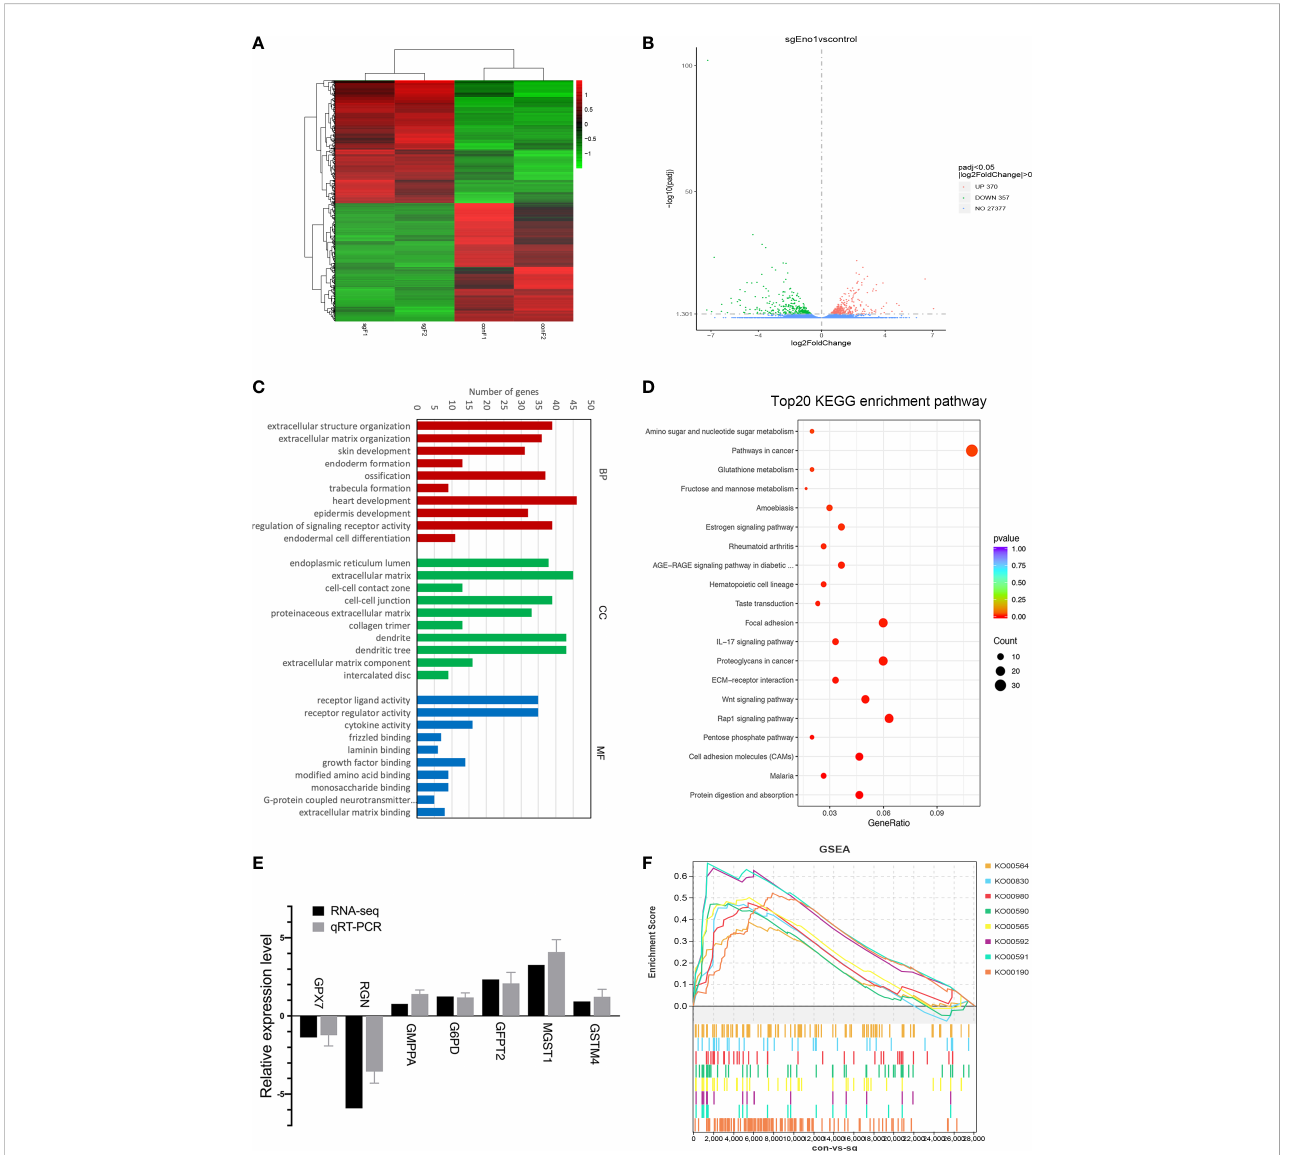
FIGURE 6 RNA-seq analysis of DEGs in control and ENO1 knockout groups. (A) A heatmap and (B) Volcano Plot of DEGs between ENO1 knockout and control cells: X-axis: the log2 (fold change); Y-axis: -log10 (Padj). Red and green dots represent the signi fi cantly upregulated and downregulated DEGs, respectively. (C) GO enrichment analysis of DEGs: X-axis, GO terms enriched in the BP, CC, and MF categories; Y-axis, the numbers of DEGs. (D) A scatterplot shows the DEGs enriched KEGG pathways: X-axis, the ratios of the DEGs involved in the pathways; Y-axis, the top 20 KEGG pathways based on -log 10 (P-value). The bubble size and color respectively denote the number of DEGs and p-value of the corresponding KEGG pathways. (E) . qRT-PCR was used to validate the RNA-seq data; the X-axis shows the 7 randomly selected DEGs and Y-axis shows their relative expression levels. Grey and black columns represent the qRT-PCR and RNA-seq expression data, respectively. (F) GSEA plots illustrate the signi fi cant enrichment of metabolism-related upregulated genes in ENO1 knockout